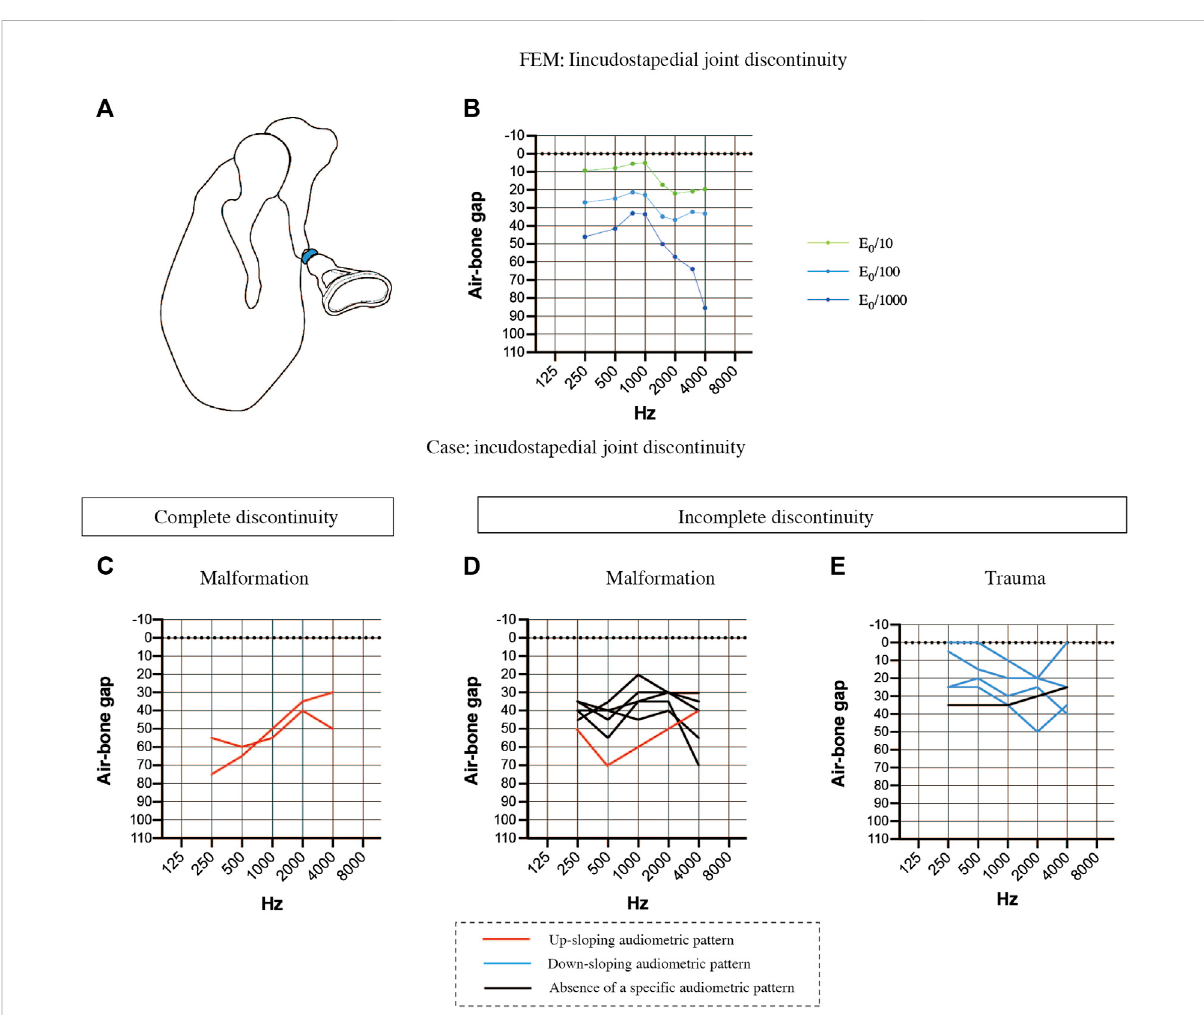
FIGURE 5 Comparisons of the air-bone gaps (ABGs) for discontinuous pathologies between the FEM and clinical cases. (A) Schematic showing complete discontinuity of the incudostapedial joint (blue). (B) Audiogram simulated using the FEM of incudostapedial joint instability. A 10-fold decrease in the Young ’ smodulus(E 0 )resulted inadown-sloping audiogram due to increases intheABGatfrequencies above 1000 Hz. A 1000-fold decrease inthe Young ’ s modulus led to an even greater ABG at frequencies above 1000 Hz as well as an increase in the ABG at 250 and 500 Hz, leading to a prominent peak at 750 – 1000 Hz. (C) Averaged audiogram for clinical cases with complete discontinuity of the incudostapedial joint due to malformation. (D) Averaged audiogram for clinical cases with incomplete discontinuity of the incudostapedial joint due to malformation. (E) Averaged audiogram for clinical cases with incomplete discontinuity of the incudostapedial joint due to trauma. All patients with a down-sloping audiogram, shown as blue lines in (E) , had incomplete discontinuity of the incudostapedial joint due to trauma, and the mean ABG for these